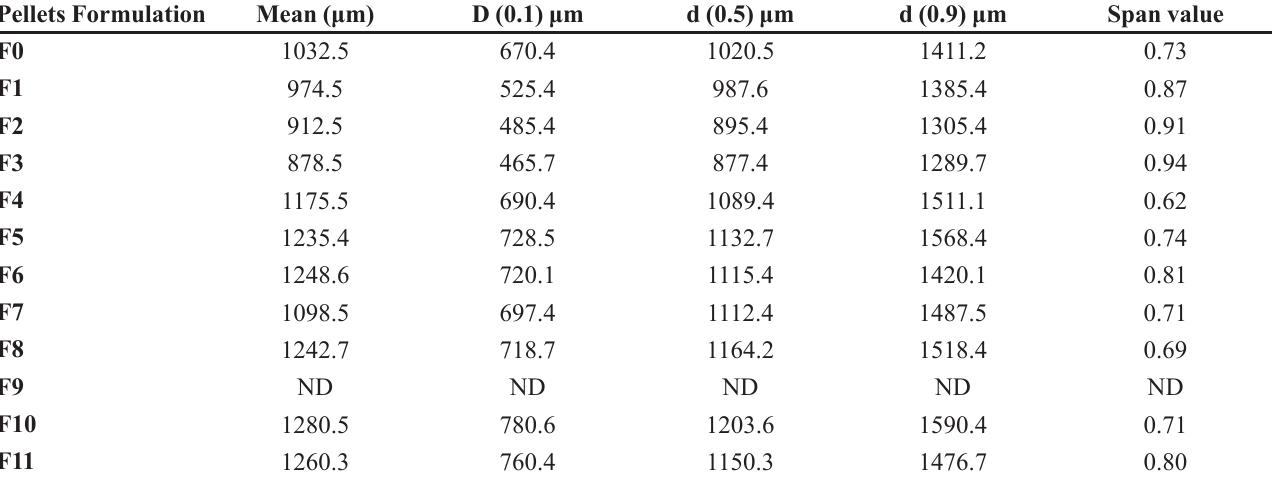
TABLE II - Volume weighted mean particle size and the d(0.1), d(0.5), d(0.9) and span values of different pellet formulae loaded with DM (10%w/w as determined by laser diffractometry) Pellets